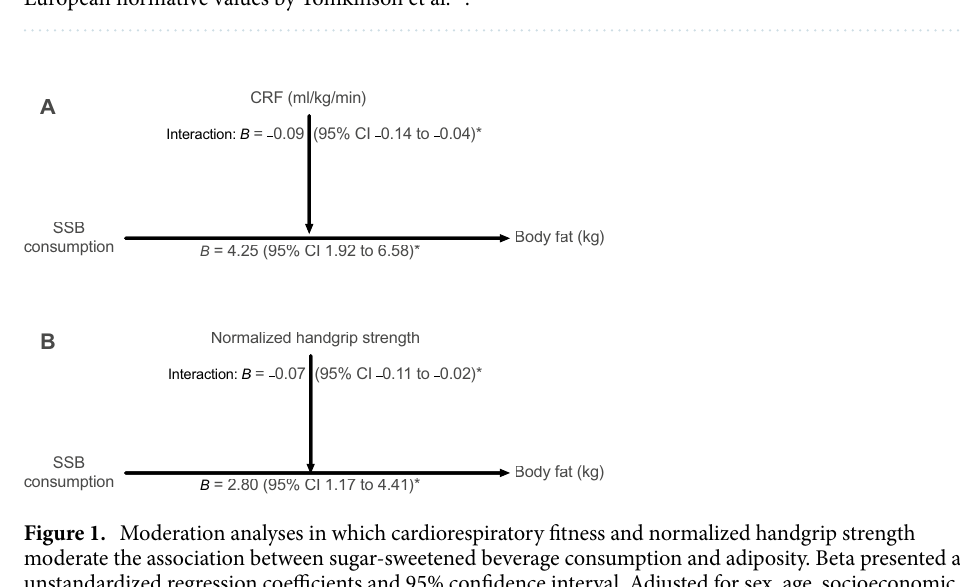
Table 1. Characteristics of the study participants (N = 475). BF body fat, BMI Body mass index, CI confident interval, CRF cardiorespiratory fitness, FFM fat-free mass, M mean, SD standard deviation, SSB Sugar- sweetened beverage. a According to the curvilineal allometric model by Nevill et al. 24 . b According to the European normative values by Tomkinson et al. 27 .